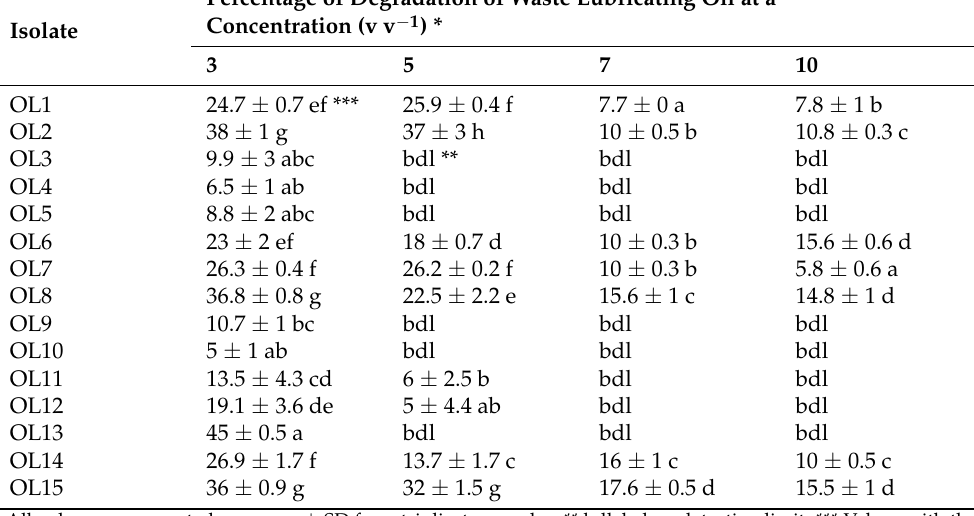
Table 1. Percentage of degradation of waste lubricating oil by each bacterial isolate, as estimated in culture broth. Percentage of Degradation of Waste Lubricating Oil at a Concentration (v v − 1 ) * Isolate